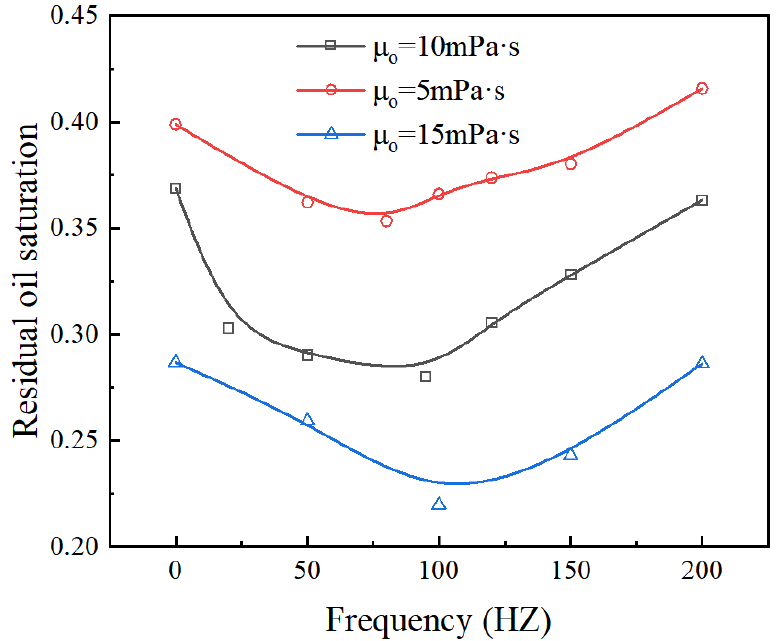
Figure 7. Comparison of residual oil saturation affected by various viscosities of oil µ o in different frequencies.